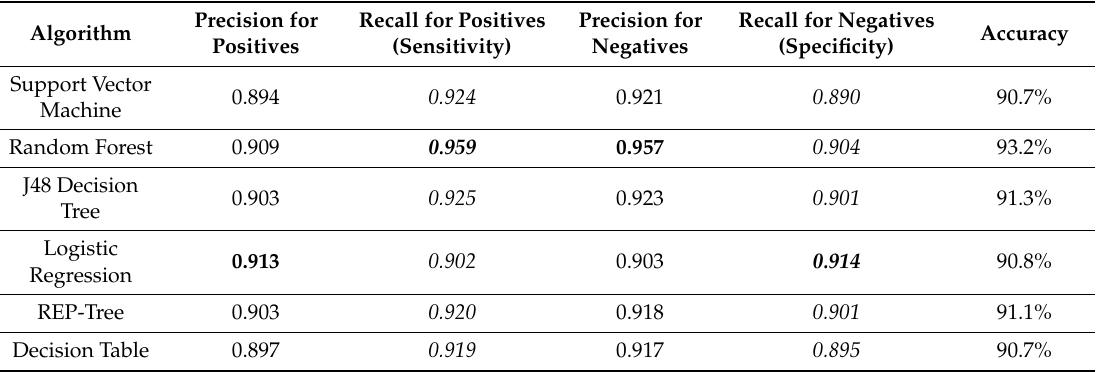
Table 2. Results obtained by Ho-Quang et al. [25] with six di ff erent algorithms: precision, recall and accuracy in classifying images as UML static diagrams 1 . Their best results in boldface. The authors report only sensitivity and specificity (in italics). We backward-computed the rest of values to better compare with our own